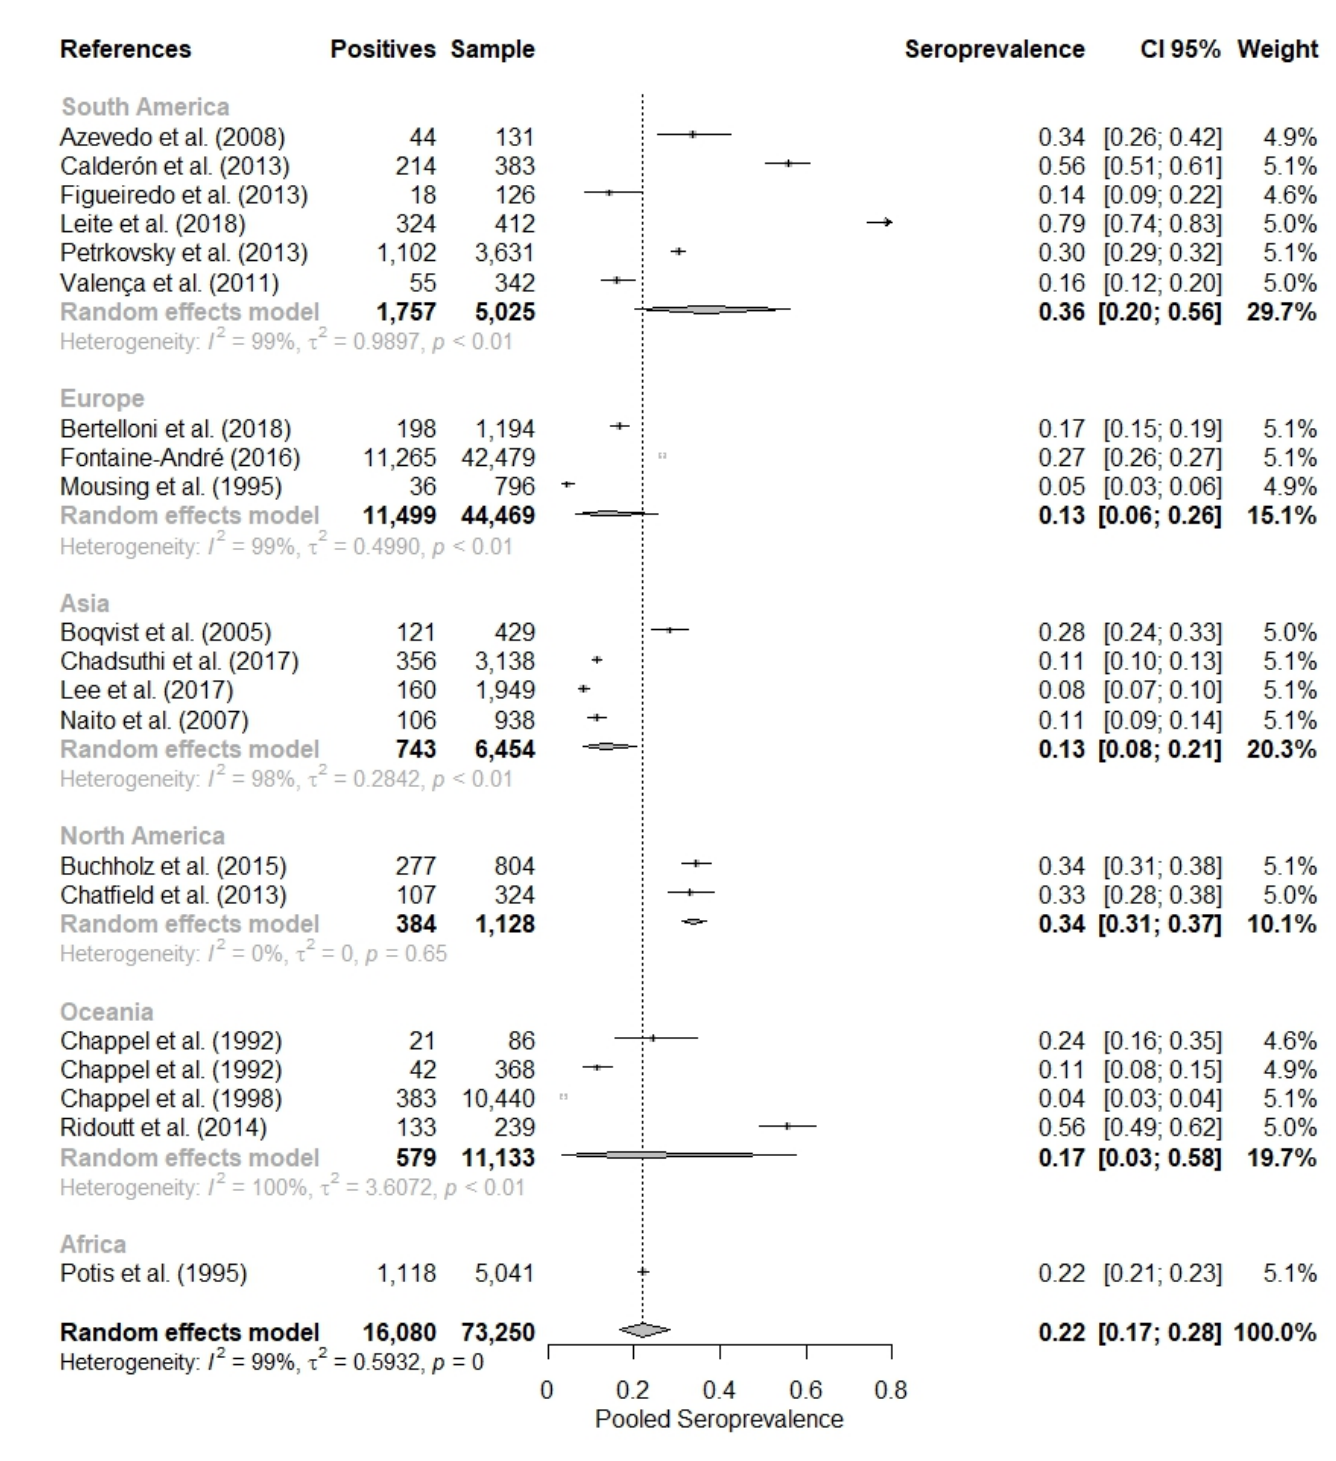
Figure 2. Combined evaluation of twenty studies on the seropositivity of leptospirosis in pigs [28–